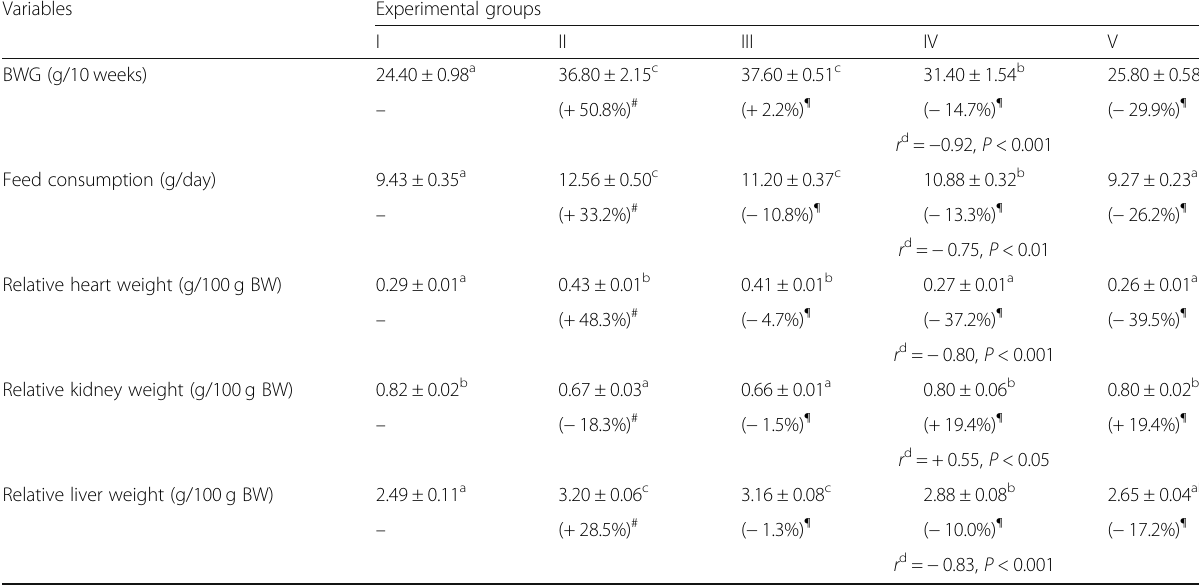
Table 3 Body weight gain (BWG), feed consumption, and relative weights of the heart, kidney, and liver of all the experimental groups, at the end of the experiments